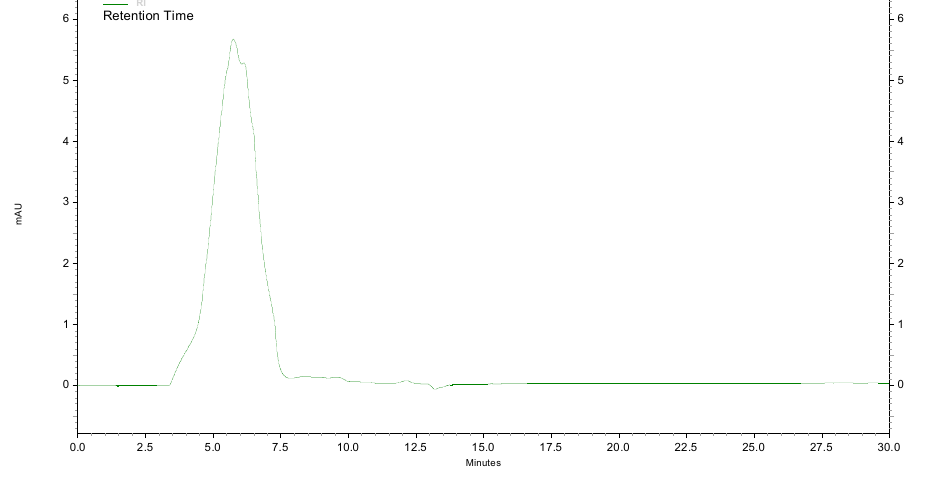
Figure 5. GPC pro fi les of purified ChS.